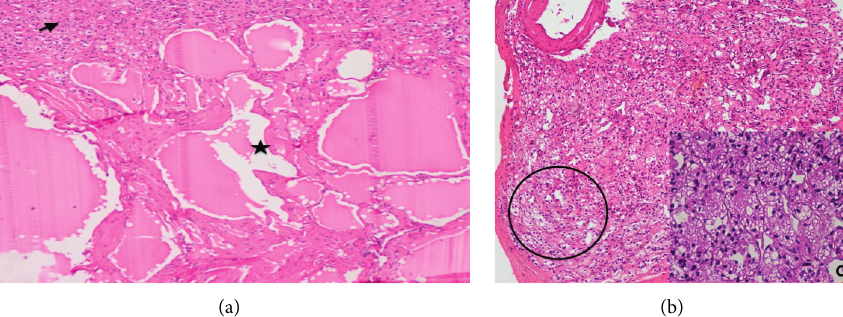
Figure 2: Histological study of the lesion: (a) a cystic space lined by flattened endothelial cells filled with blood (star) associated to a proliferation of well-defined clear cells (arrow) (H&Ex100). (b) Alveolar disposition of the clear cells (circle) (H&Ex200). (c) Adrenocortical adenoma